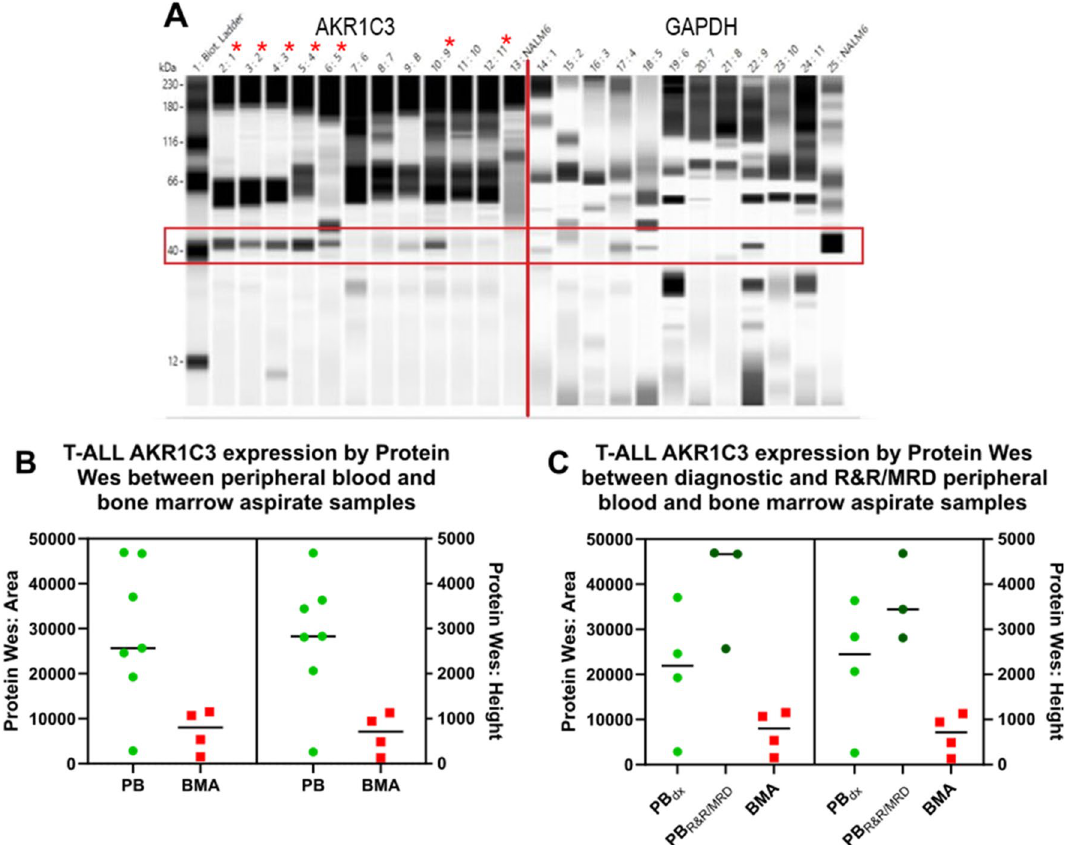
Figure 4. AKR1C3 expression by Protein Wes Simple in blood and bone marrow. ( A ) Increased expression of AKR1C3 by Protein Wes in peripheral blood specimens (indicated by red *) compared to the marrow aspirate specimens and control GAPDH expression. ( B ) In T-ALL cases with AKR1C3 expression in peripheral blood (PB) versus bone marrow aspirate (BMA), in which elevated expression is observed in PB samples regardless of their timepoint (Protein Wes Area t-test: P = 0.0277; Protein Wes height t-test: P = 0.0166). ( C ) When PB samples were segregated into diagnostic (PBdx) and samples of relapsed/refractory and/or minimal residual